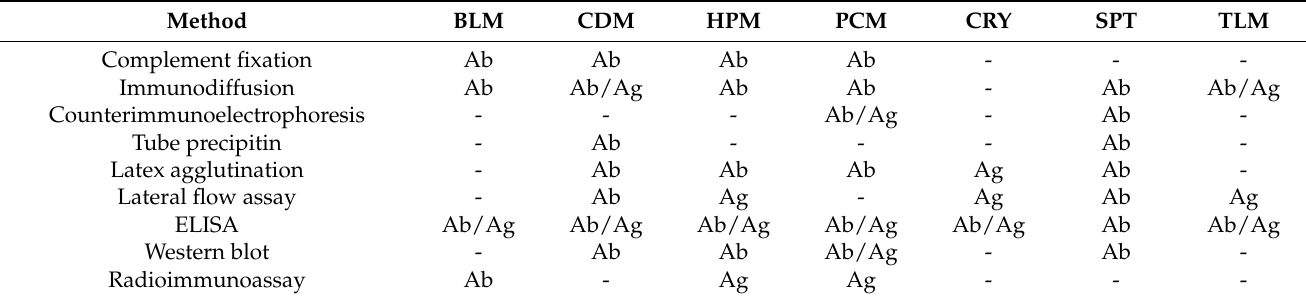
Table 1. Immunologic methods used for antigen or antibody detection for the diagnosis of the major endemic